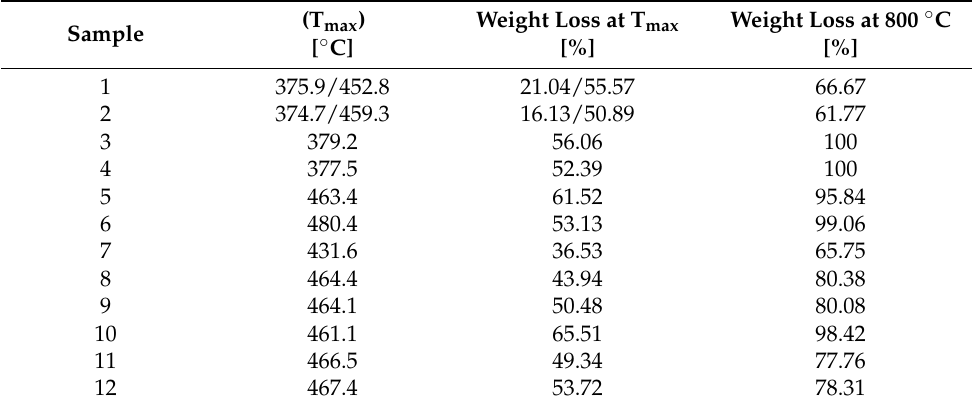
Table 2. The temperature of the maximum weight loss (T max ) and the relative weight